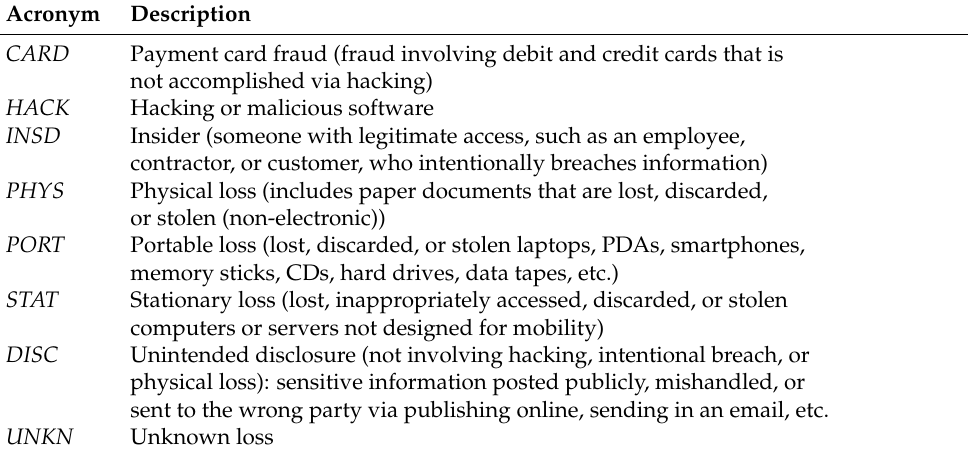
Table 2. The type of the considered breaches with their descriptions.